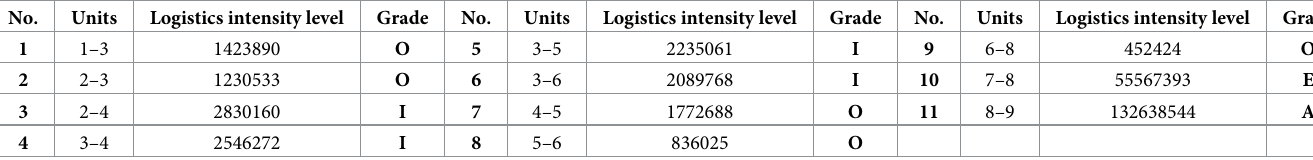
Table 6. Logistics intensity from production unit to production unit.